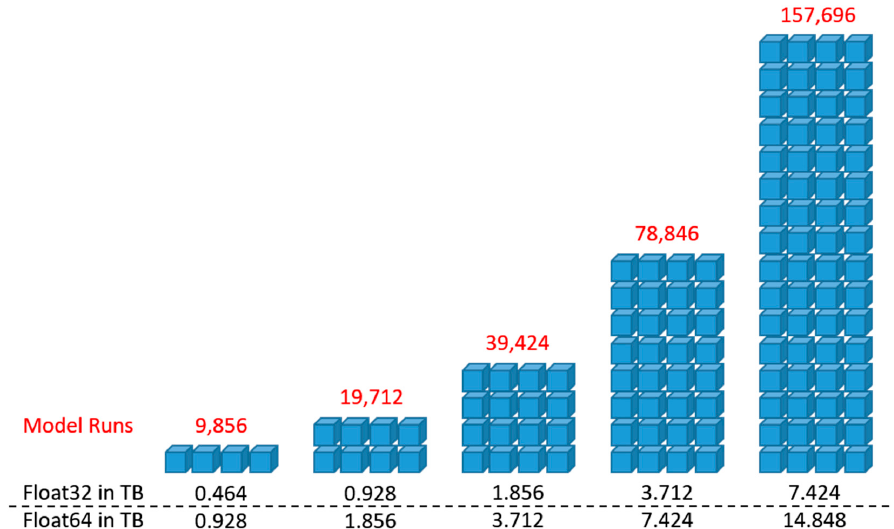
Figure 1. Spatially-Explicit Uncertainty and Sensitivity Analysis (SEUSA) memory consumption. Comparison of the working memory consumption to generate the suitability surfaces, depending on the number of model runs.